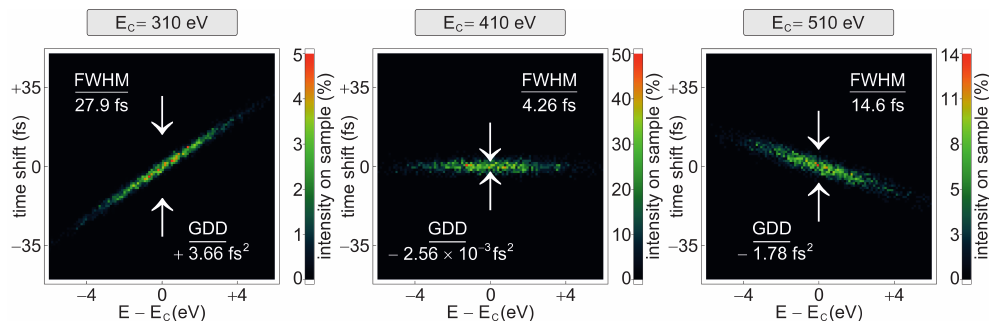
Figure 7. Chirped-pulse compression across the range (310–510) eV for a constant time-bandwidth product of the source pulse with a spectral width of 5eV and a temporal length of ( 37.9 ± 0.4 ) fs. Displayed is the distribution in the sample plane with the pulse duration (FWHM) and the residual GDD in units of [ fs 2 ] . The “intensity on sample” is scaled relative to that of the source, including the transmission efficiency from Table 3. For each Monte-Carlo simulation, 1.5 × 10 5 photons are